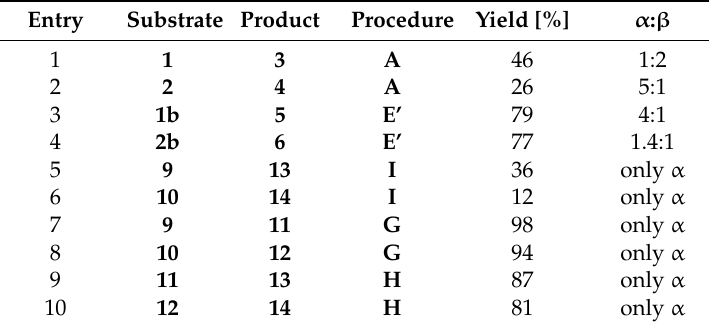
Table 1. Preparation of compounds 3–14 .